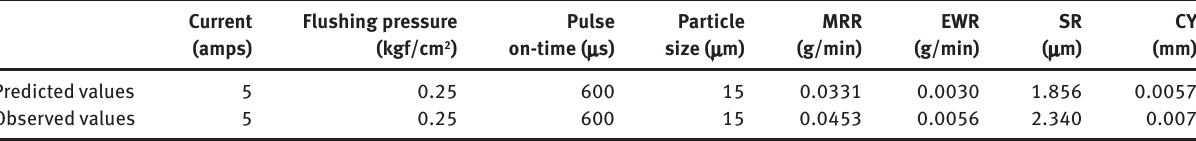
Table 5 Predicted vs. observed